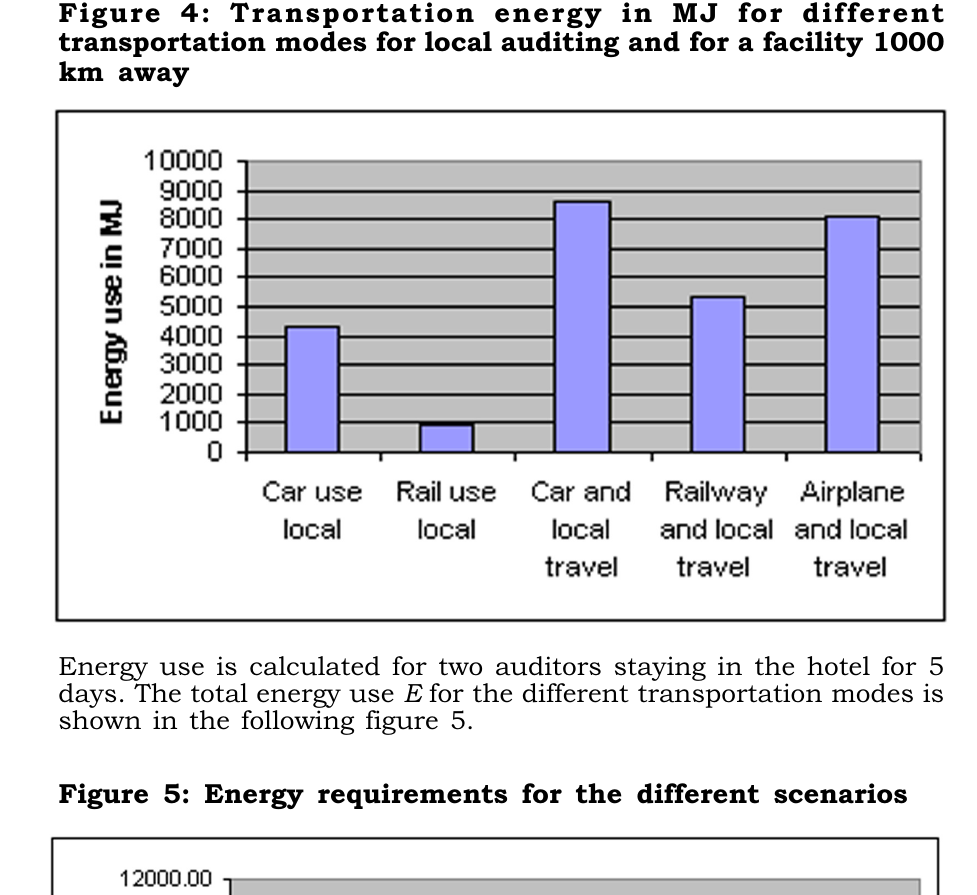
Figure 4: Transportation energy in MJ for different transportation modes for local auditing and for a facility 1000 km away